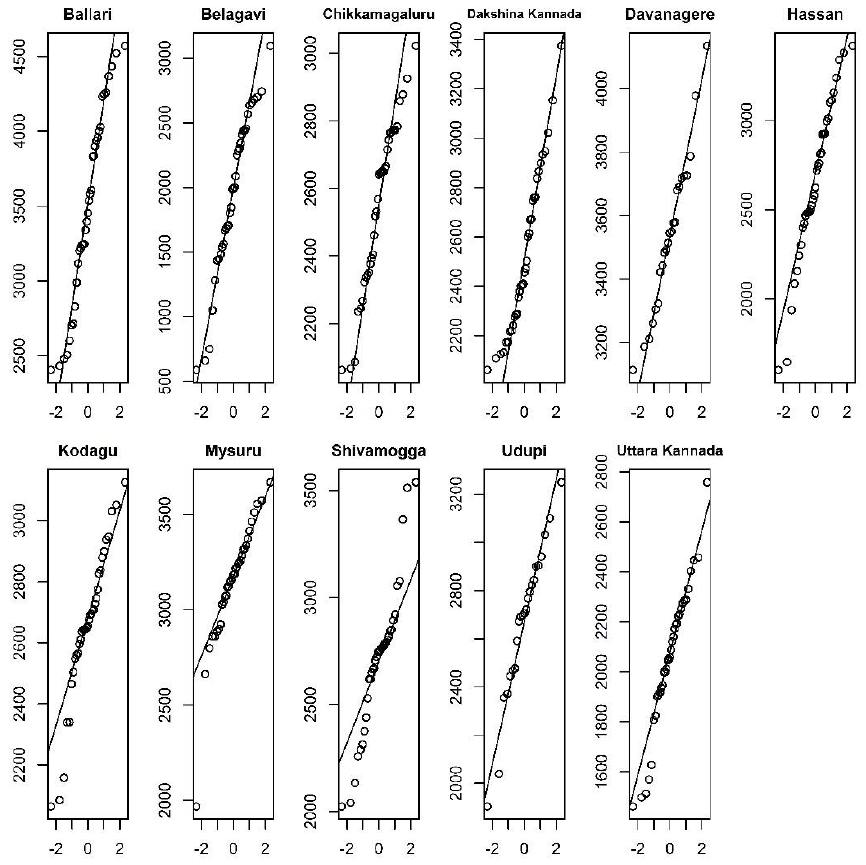
Figure 5. Normal Q–Q plot for kharif rice yields in 11 study districts of Karnataka. Figure 5. Normal Q – Q plot for kharif rice yields in 11 study districts of Karnataka. Table 4. Rice yield prediction equations using stepwise multiple linear regression for different Table 3. Statistics of rice yield variability in eleven study districts. districts of Karnataka during 2021 at preharvest (F3)